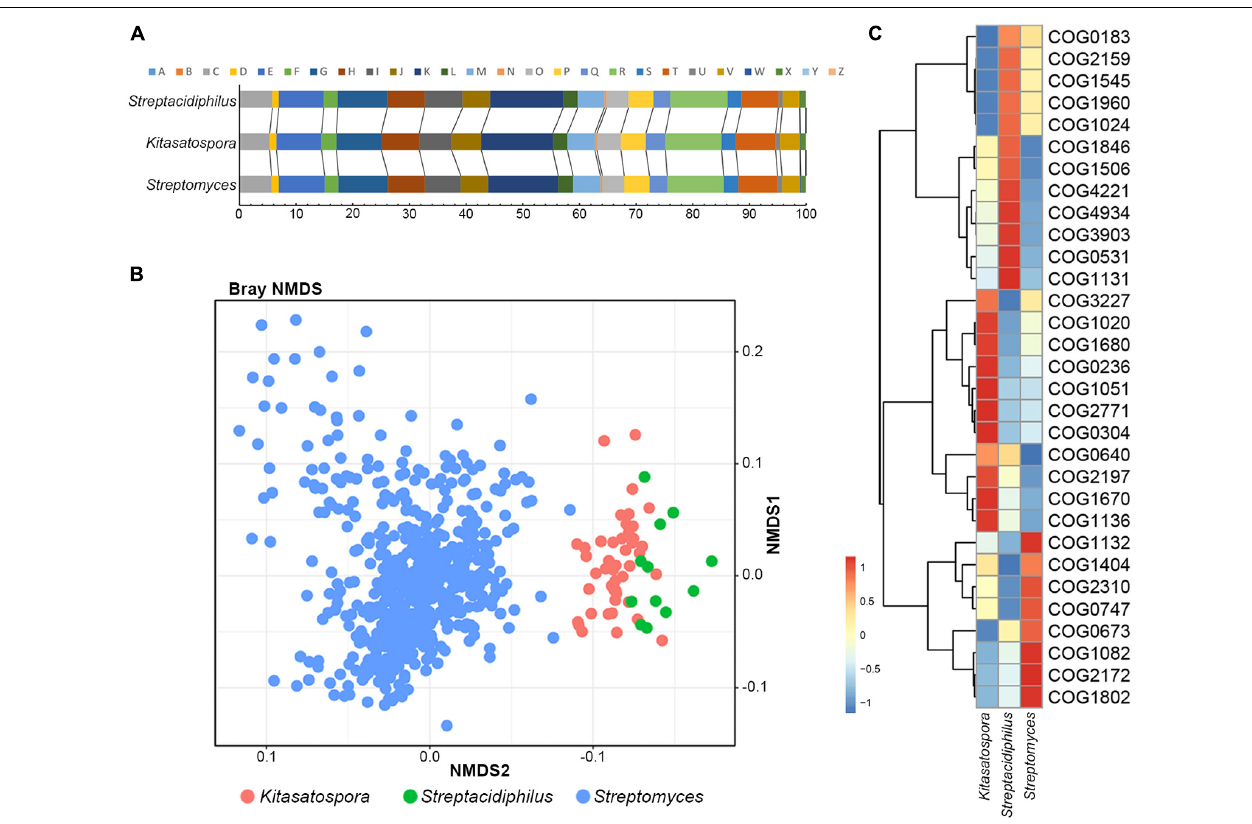
FIGURE 2 | Correlation and divergence of functional traits between genera. (A) Stack bar chart showing functional proportions of genes based on COG categories. (B) Non-metric multidimensional scaling (NMDS) plot of COGs showing distinct clustering of each genus. (C) Heatmap of COGs that significantly contributed most to the dissimilarity between different genera. Relative abundance of the COGs is presented after transformation with a